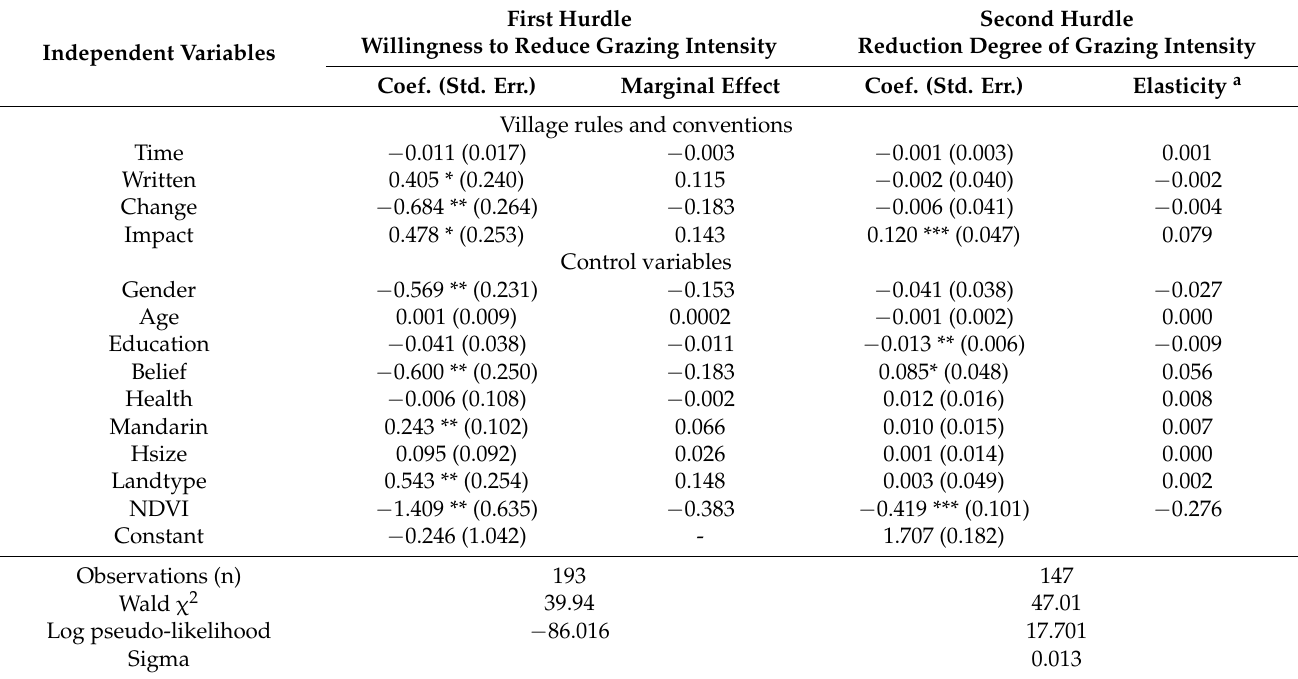
Table 6. Estimation results of the impact of VRC on WTR and RD